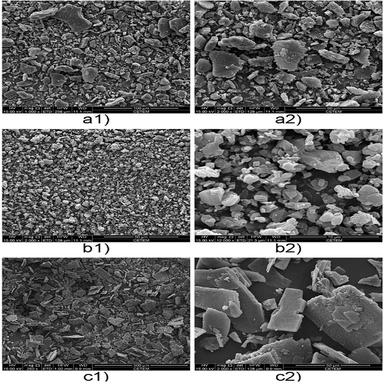
SEM photomicrographs of OLZ (a1) and (a2) A with 1000× and 2000× magnification, respectively; (b1) and (b2) B with 2000× and 12,000×, magnification respectively; (c1) and (c2) C with 250× and 2000× magnification, respectively.